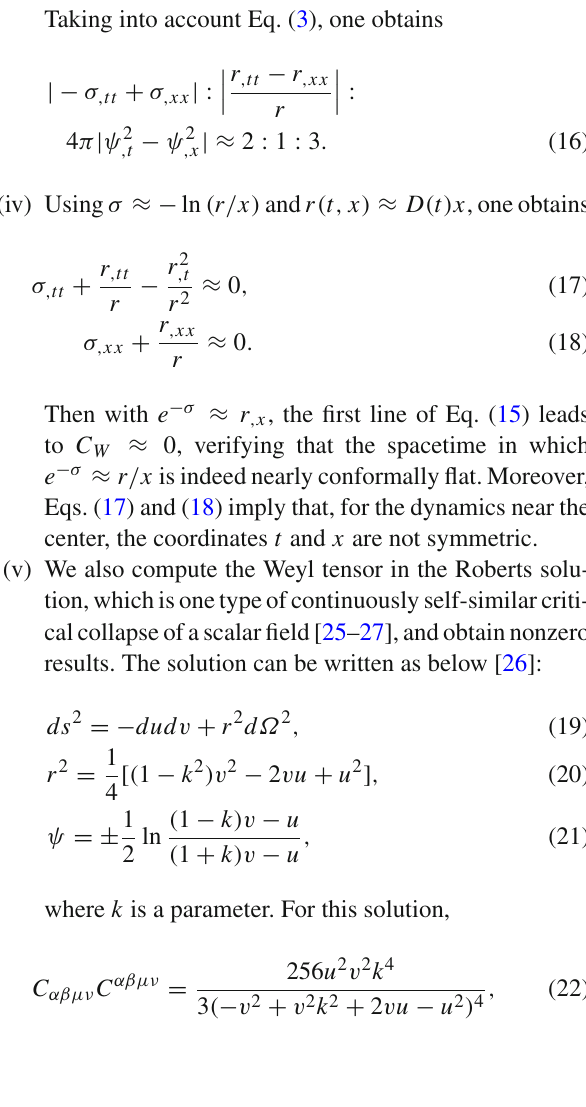
Fig. 4 ( − σ,ψ) vs. − ln τ . The numerical results are fit for 4 . 96 ≤ − ln τ ≤ 8 . 55, correspondingly for 0 . 4730 ≤ t ≤ 0 . 5945. a The numerical results on − σ vs. − ln τ are fit according to f (ζ) = a ζ + ln [ 1 + b cos (ωζ + c ) ] + d . The period for σ is T σ ≈ 1 . 795, and ω is fixed to be ω = 2 π/ T σ = 3 . 50. The fitting results are a = − 0 . 5028 ± 0 . 0015, b = 0 . 2287 ± 0 . 0018, c = − 1 . 482 ± 0 . 009, and d = 0 . 1757 ± 0 . 0096. b The numerical results on ψ vs. − ln τ are